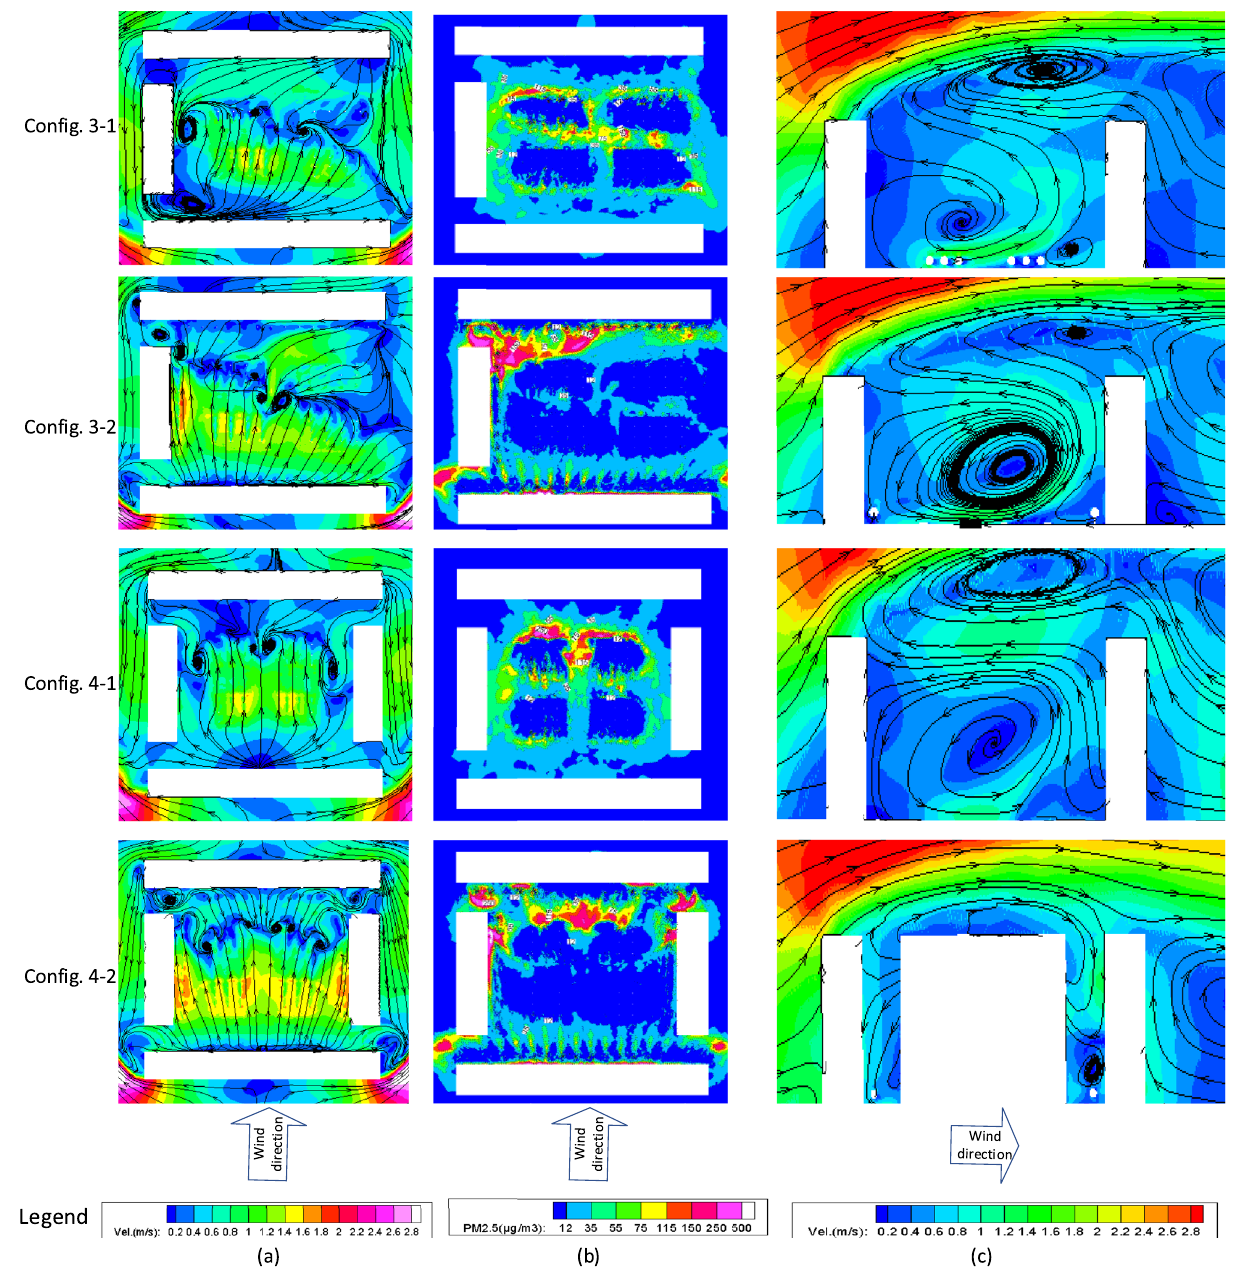
Figure 7. Plan view of the ( a ) wind velocity; ( b ) PM 2.5 concentration at pedestrian height, and ( c ) lateral view of the wind velocity for Configuration-3 and